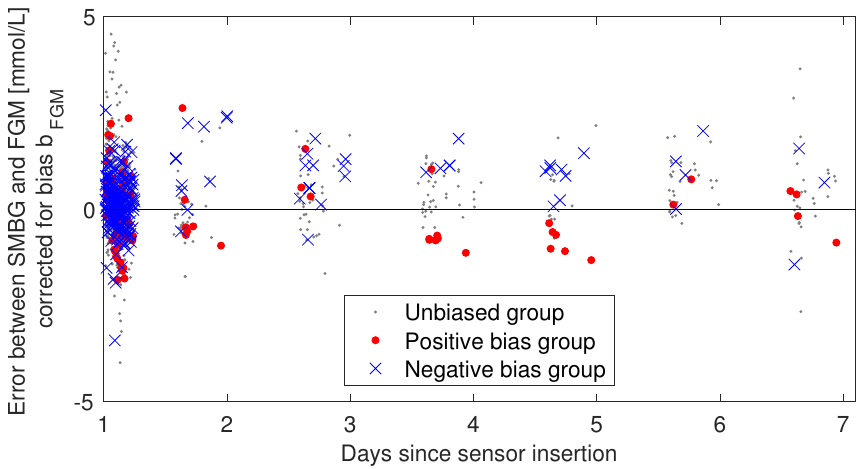
Figure A2. Same plot as in Figure 6, but with individual bias correction ( b FGM ) applied. Using biases found from day 1 to correct day 2–7 data seems to give over-correction, at least in the negative bias